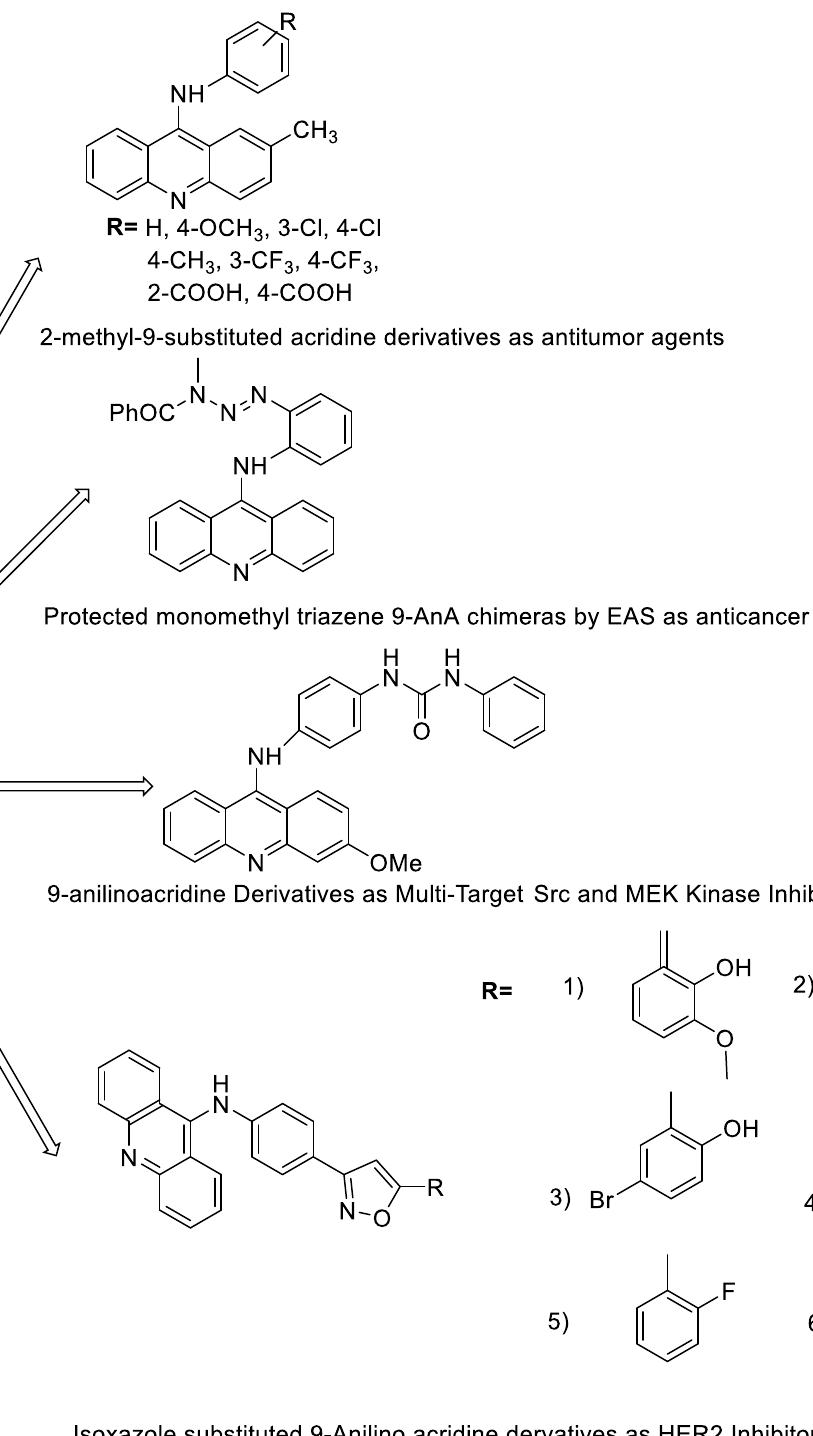
Figure 5. 9-anilino acridine derivatives showing antitumour activity.